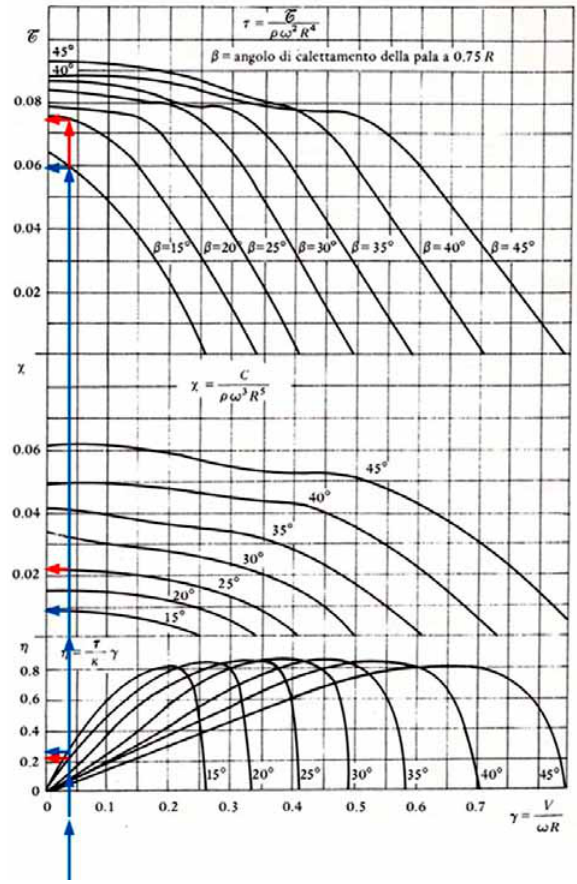
Fig. 3. Propeller Plots (NACA four-blades). From (Lausetti